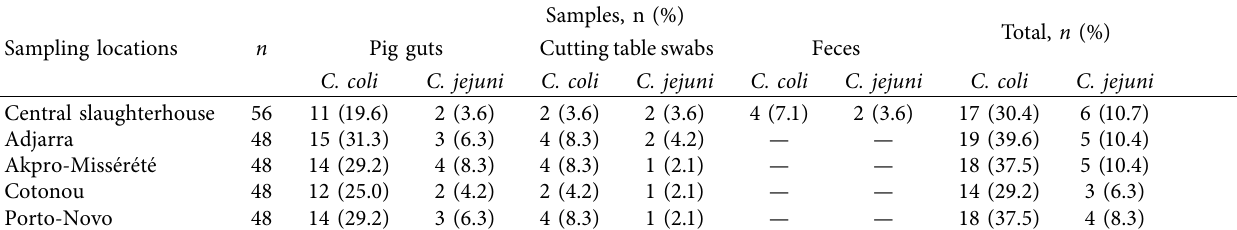
Table 4: Distribution of C. coli and C. jejuni according to samples and sampling locations.